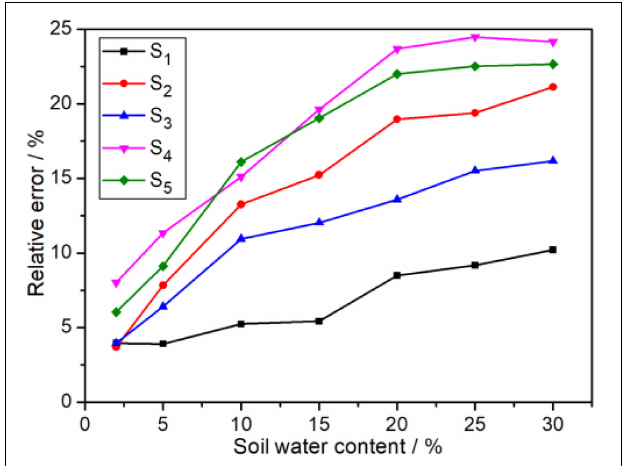
FIGURE 4 | Effects of soil water content on detection